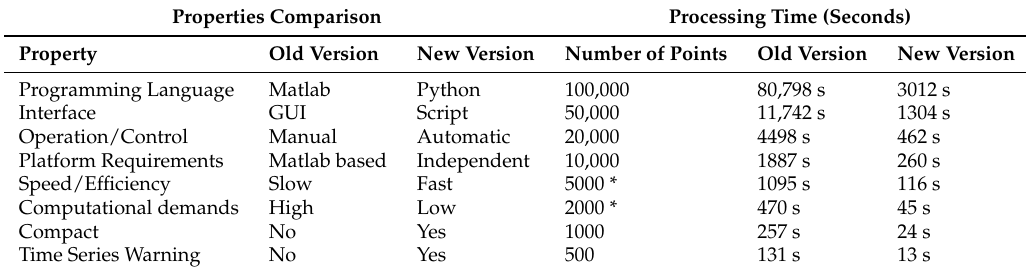
Table 5. Properties and processing time comparison between new and old